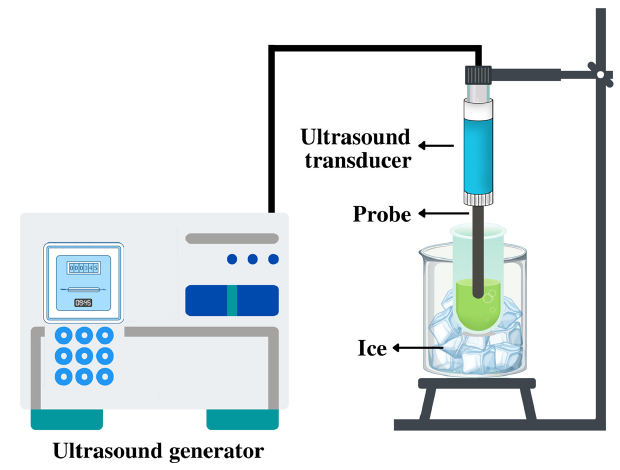
Figure 6. Schematic of UAE assembly with ultrasound probe